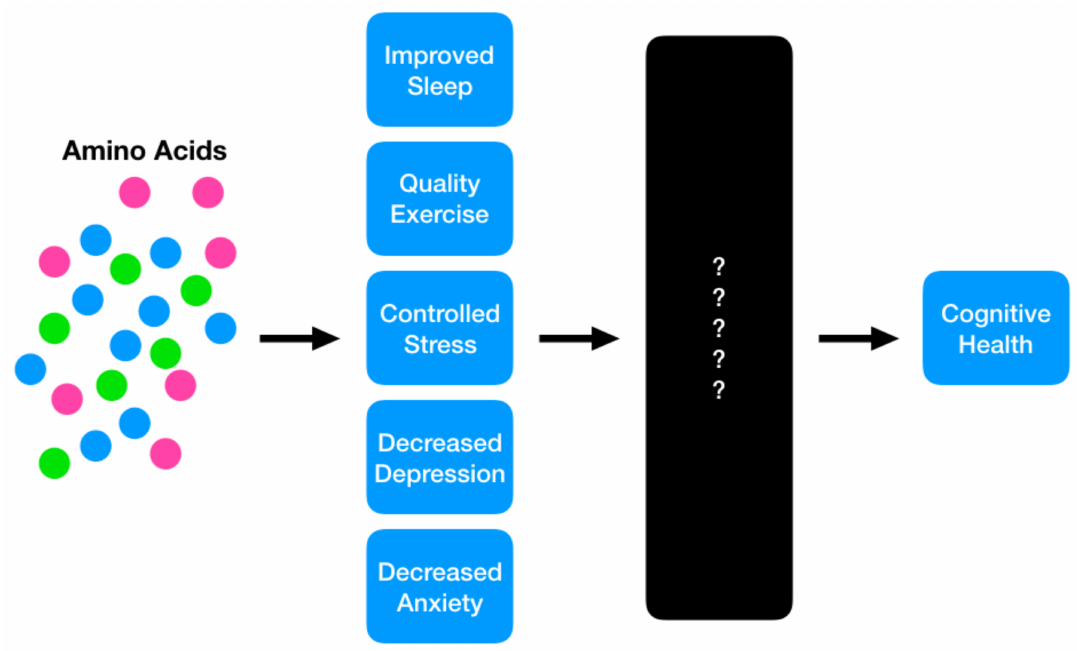
Figure 2. The proposed model in which protein and its constituent amino acids may play a role in mitigating risk for future cognitive decline. The current state of the science suggests a strong potential for these nutritional interventions to achieve positive benefits; however, the causal mechanisms are still a ‘black box,’ requiring future